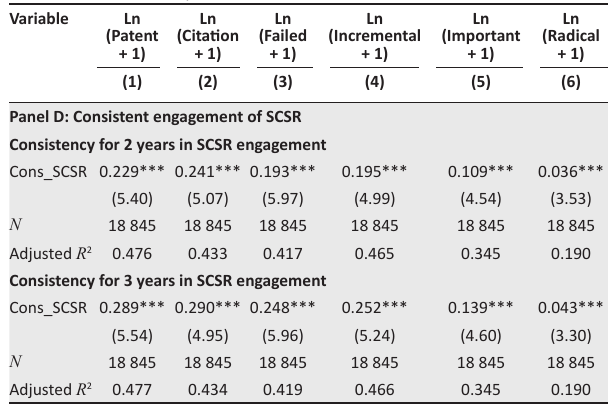
TABLE 5D: Further analyses.